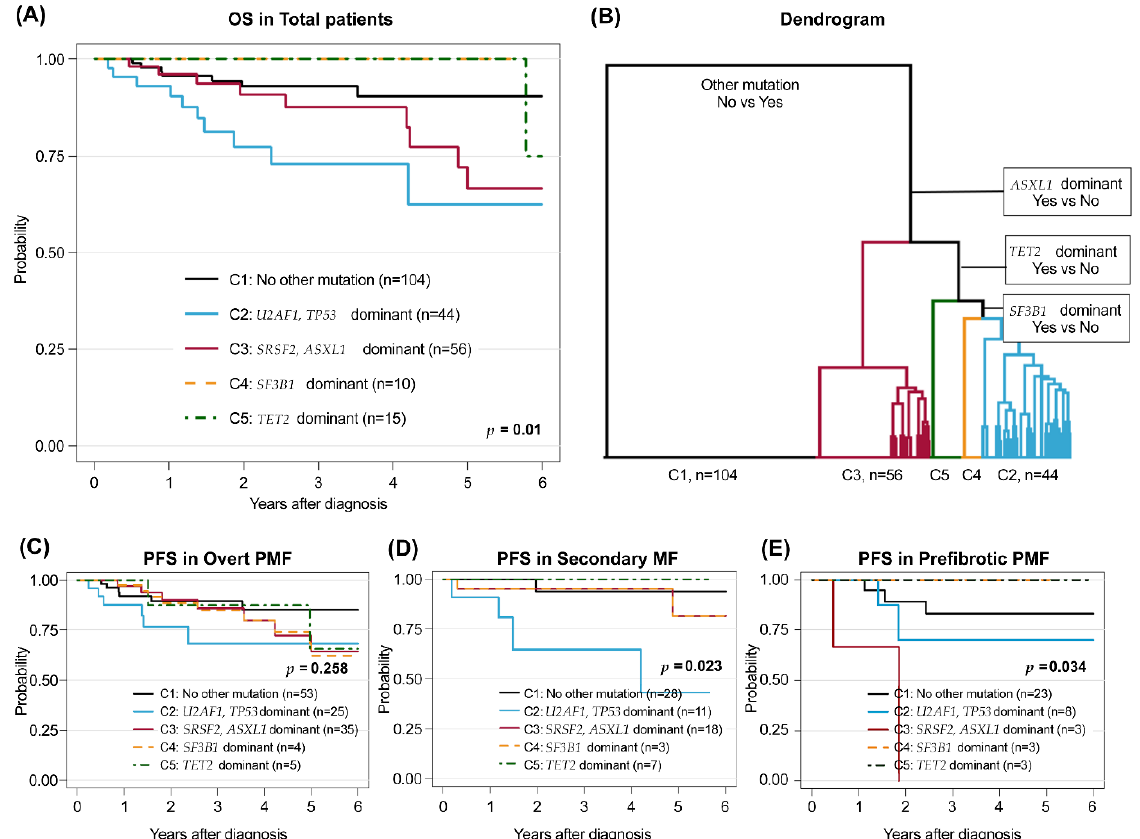
Figure 3. Hierarchical clustering in the overall cohort ( A ) applied to overall survival (OS) and ( B ) dendrogram. PFS by clusters in ( C ) primary myelofibrosis (PMF), ( D ) secondary myelofibrosis (SMF), and ( E ) prefibrotic myelofibrosis (pre-PMF). For detailed p -value between clusters is described in supplementary Table S3.